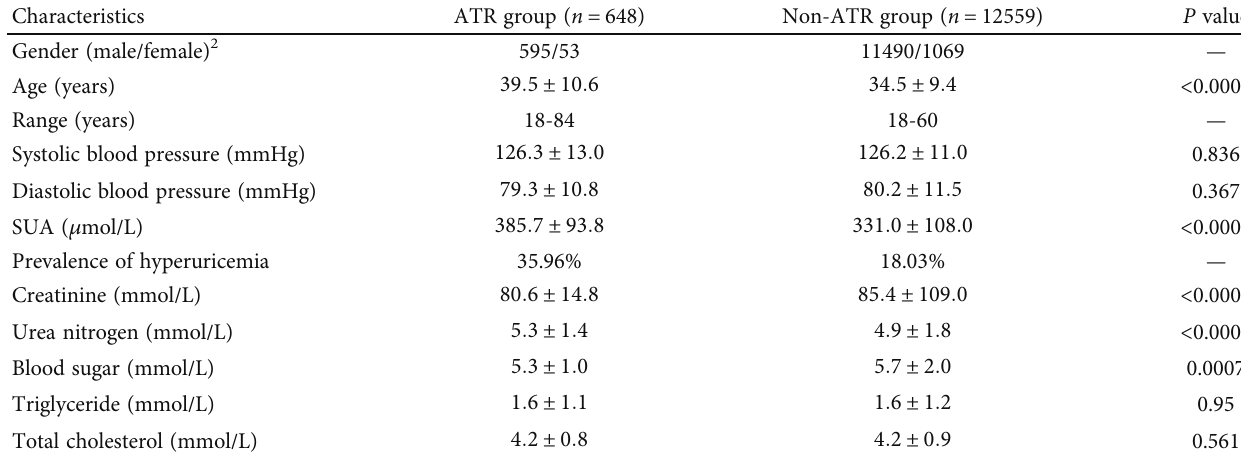
Table 1: Demographic and clinical features in subjects with and without ATR 1